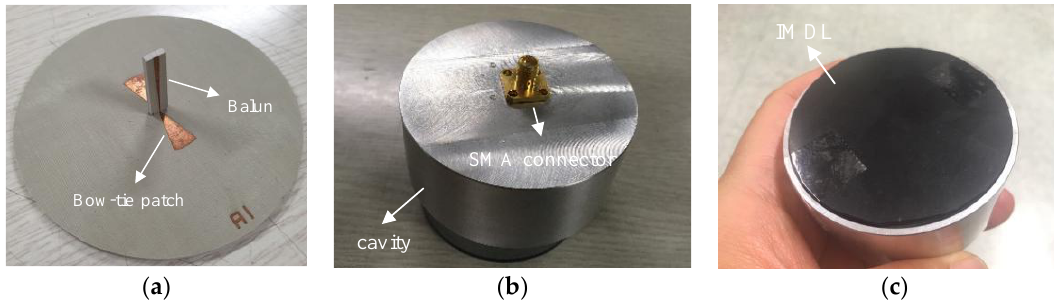
Figure 7. Fabricated antenna ( a ) bow-tie antenna and balun; ( b ) cavity with SMA connector; ( c ) impedance-matching dielectric layer on top of the bow-tie substrate.